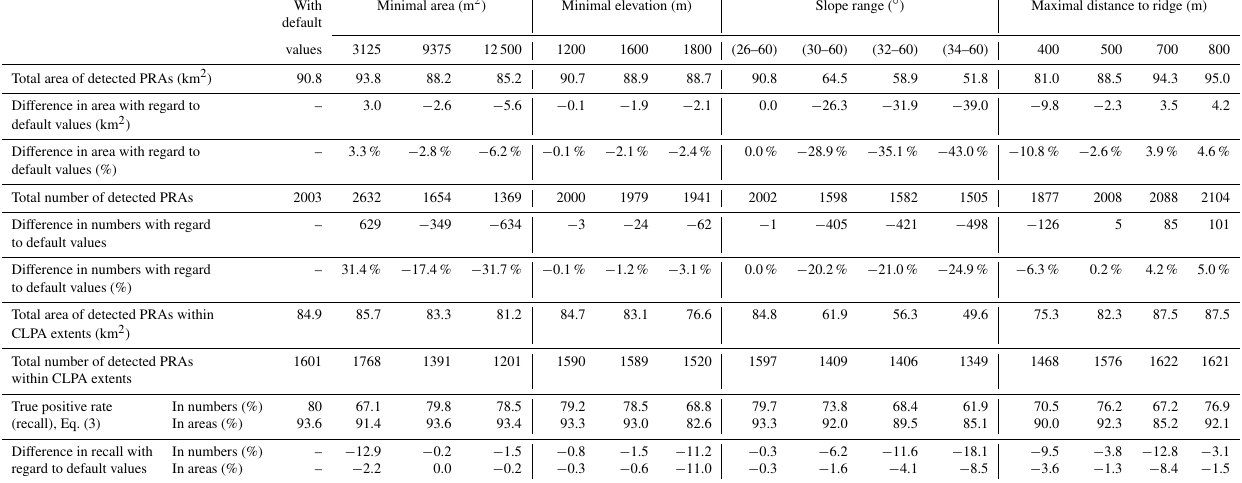
Table 6. Parametric study: effect of minimal area size, minimal elevation, slope range and maximal distance to ridge on PRA detection, Mont Blanc massif. Total area of detected PRAs and total number of detected PRAs are those of the part of the massif covered by CLPA (Table 1). For the PRA detection, in each column, only the considered factor varies. All other factors and the DEM resolution are set to their default values (Fig. 3), and forest cover data are from DB forest IGN. For the determination of the validation sample, all factors and DEM resolution are set to their default values (Fig. 4) and forest cover data are from DB forest